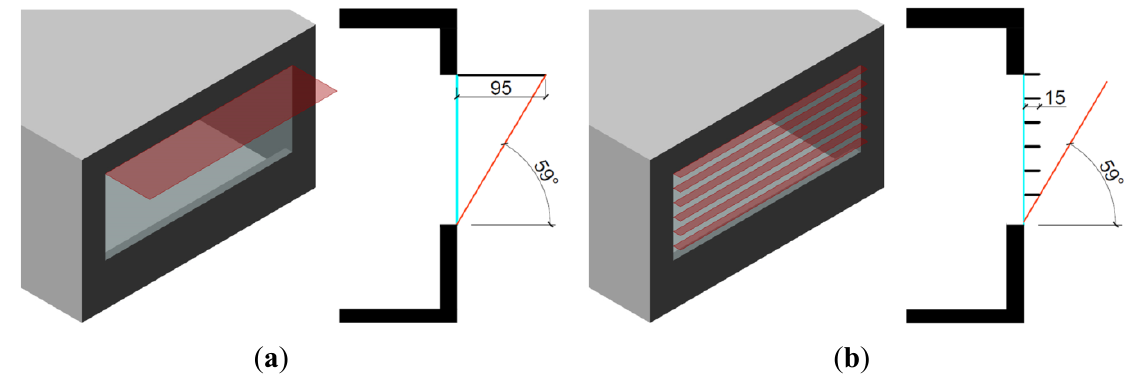
Figure 3. ( a ) Scenario NCC1; ( b ) scenario NCC2.